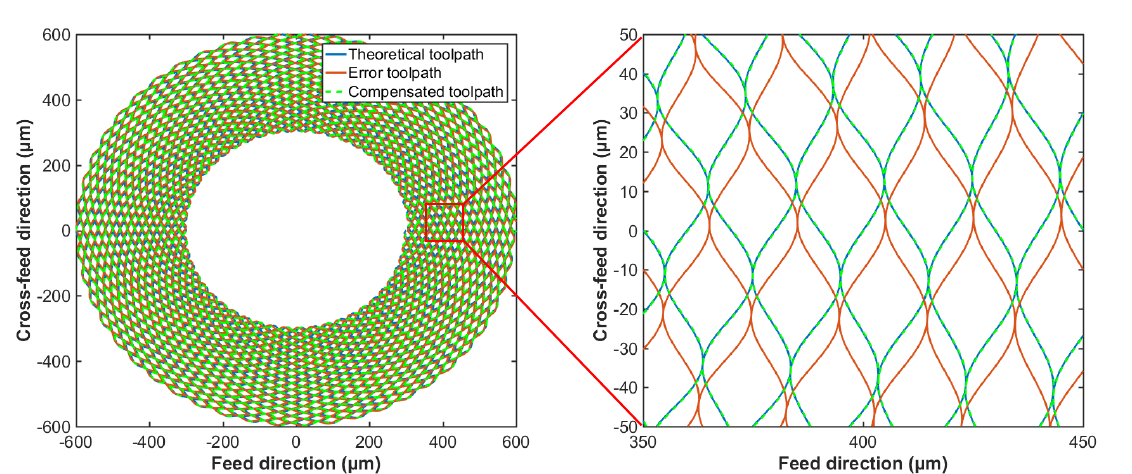
Figure 5. The corresponding hierarchical surface simulation:( a ) Non-contact-mode surface; ( b ) Contact-mode surface and ( c ) Cross-mode surface.